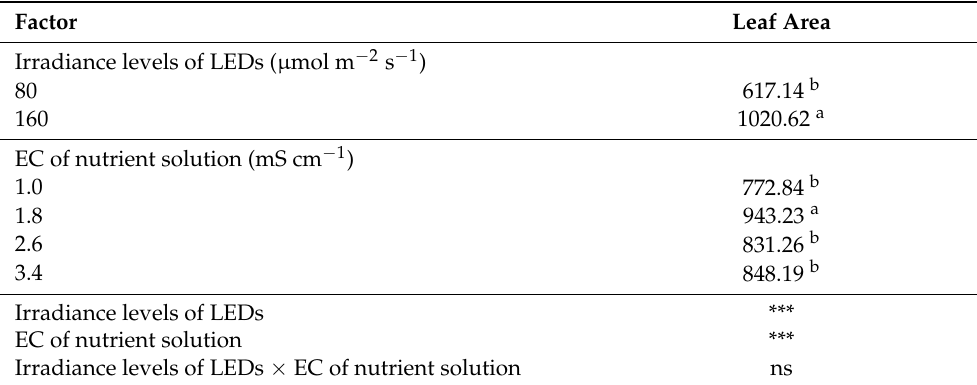
Table 4. Effects of LED irradiance levels and nutrient solution EC on leaf area (cm 2 /plant) in lemon